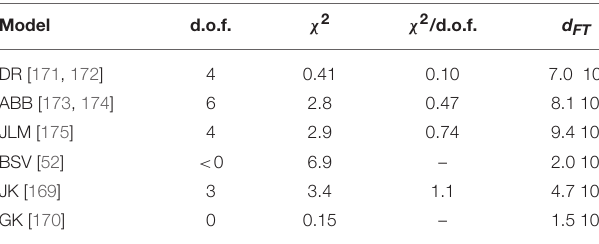
0.022 it is about 4 times ∼